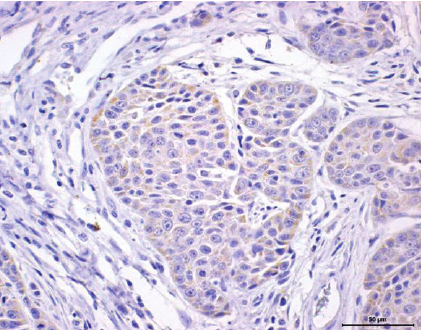
Figure 5: Immunolocalization of COX-2 in nasal carcinoma after treatment. Positive signal can be observed as the brown color in the cytoplasm of the cells or in the cytoplasm with hematoxylin counterstain. Bar = 50 𝜇